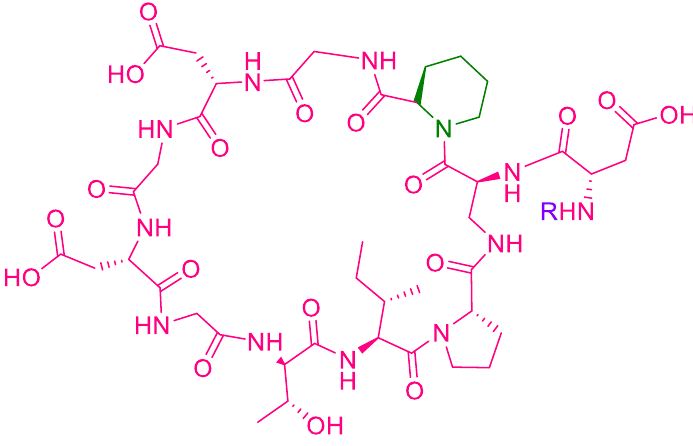
Figure 80. Glycinocin analogues.